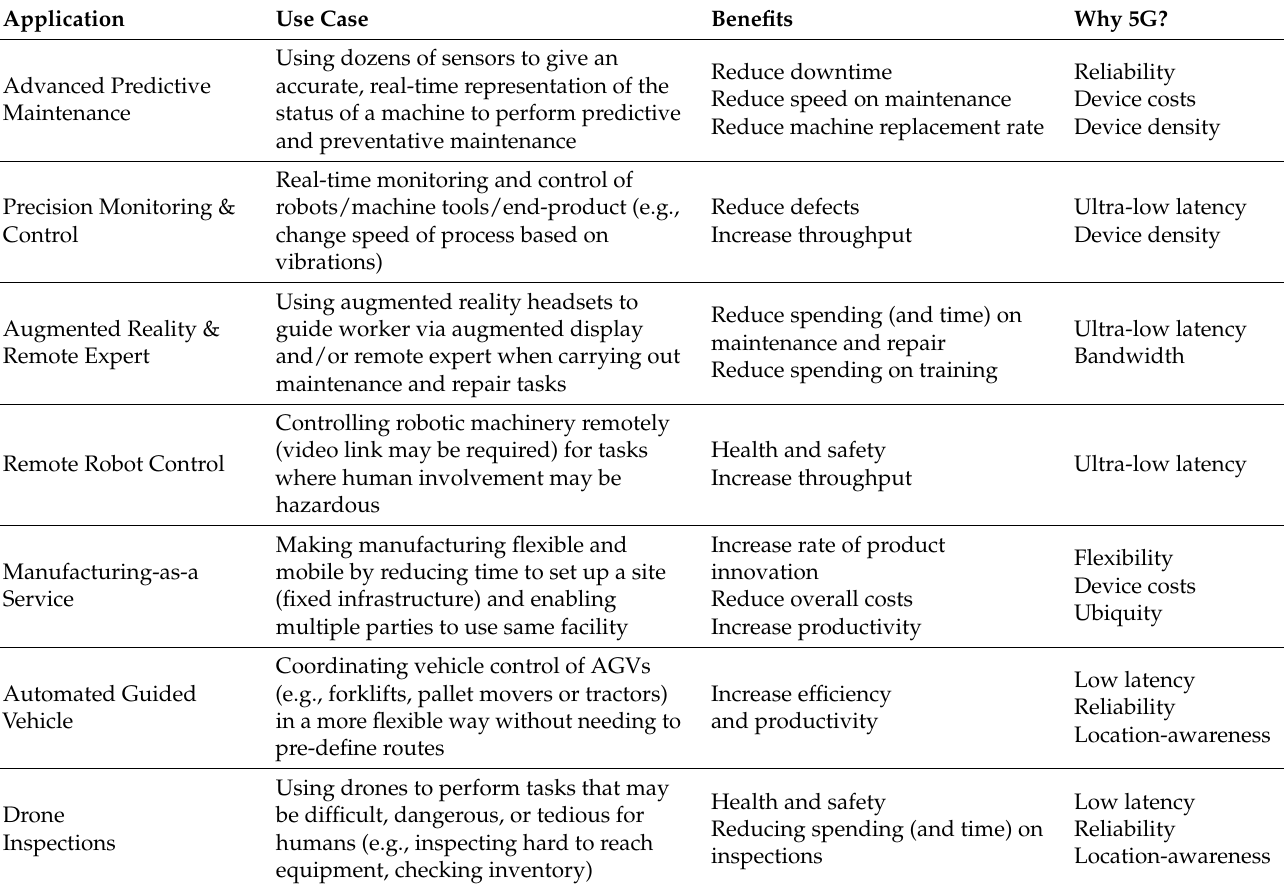
Table 5. Manufacturing use cases enabled by 5G